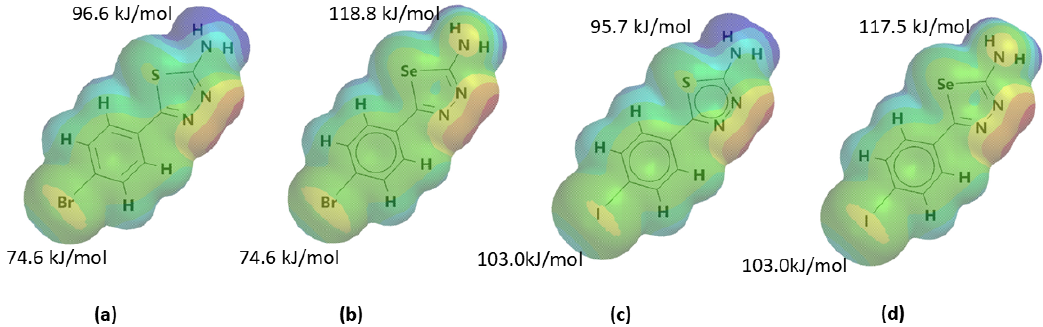
Figure 3. Molecular electrostatic potential maps (MEPs) of the ( a ) T1-S-Br ( b ) T1-Se-Br ( c ) T1-S-I ( d ) T1-Se-I. Table 1. MEP (kJ/mol) data for chalcogen and halogen atoms of the different target analogs.